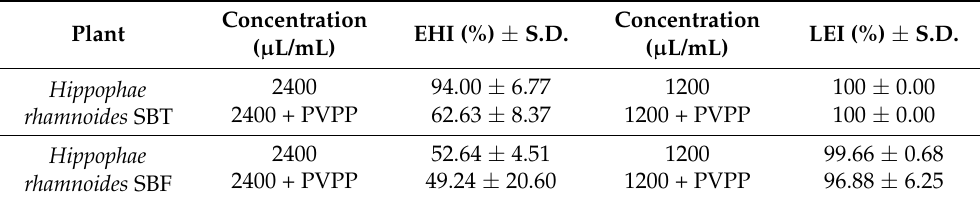
Table 5. Gastrointestinal nematode (GIN) larval-exsheathment inhibition (LEIA) and egg-hatch inhi- bition (EHT) percentages ( ± standard deviation) observed for 1200 and 2400 µ g/mL concentrations in LEIA and EHT, respectively, of the two different sea buckthorn berry juices examined in this study (SBT and SBF) with and without polyvinylpolypyrrolidone (PVPP) addition. SBT: sea buckthorn from Tuscany, Italy; SBF: sea buckthorn from Friuli-Venezia Giulia, Italy.